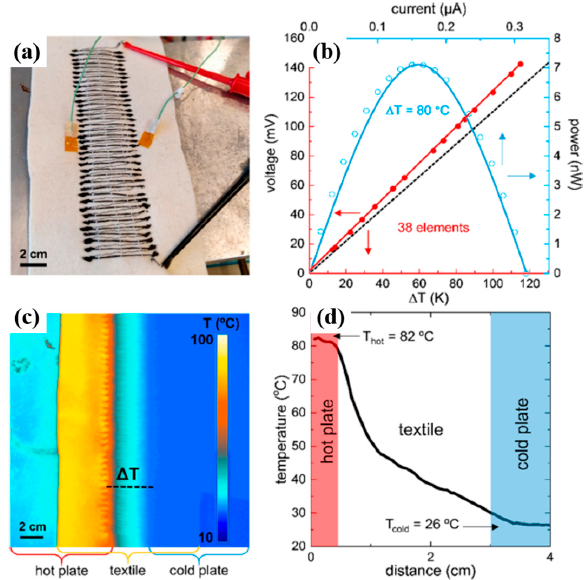
Figure 13. ( a ) The all ‐ organic in ‐ plane embroidered textile thermoelectric (TE) device with 38